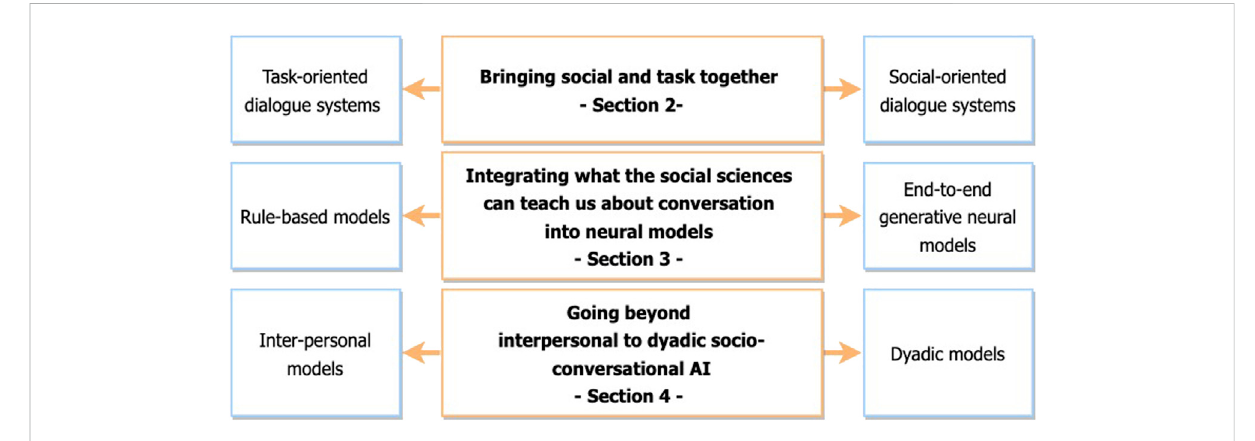
FIGURE 1 The three challenges for gathering different research in conversational